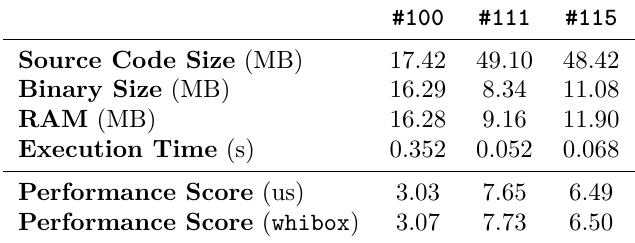
Table 2: Performances of the winning implementations measured under iMac (27-inch, late 2012) with a 3.4 GHz Intel Core i7 processor and macOS Mojave Version